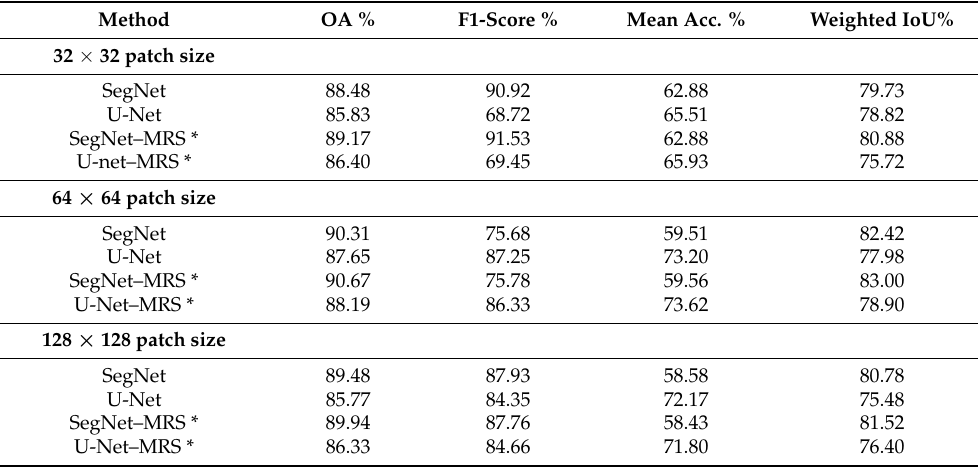
Table 16. Experimental results for ZH 17 image of the Zurich Summer